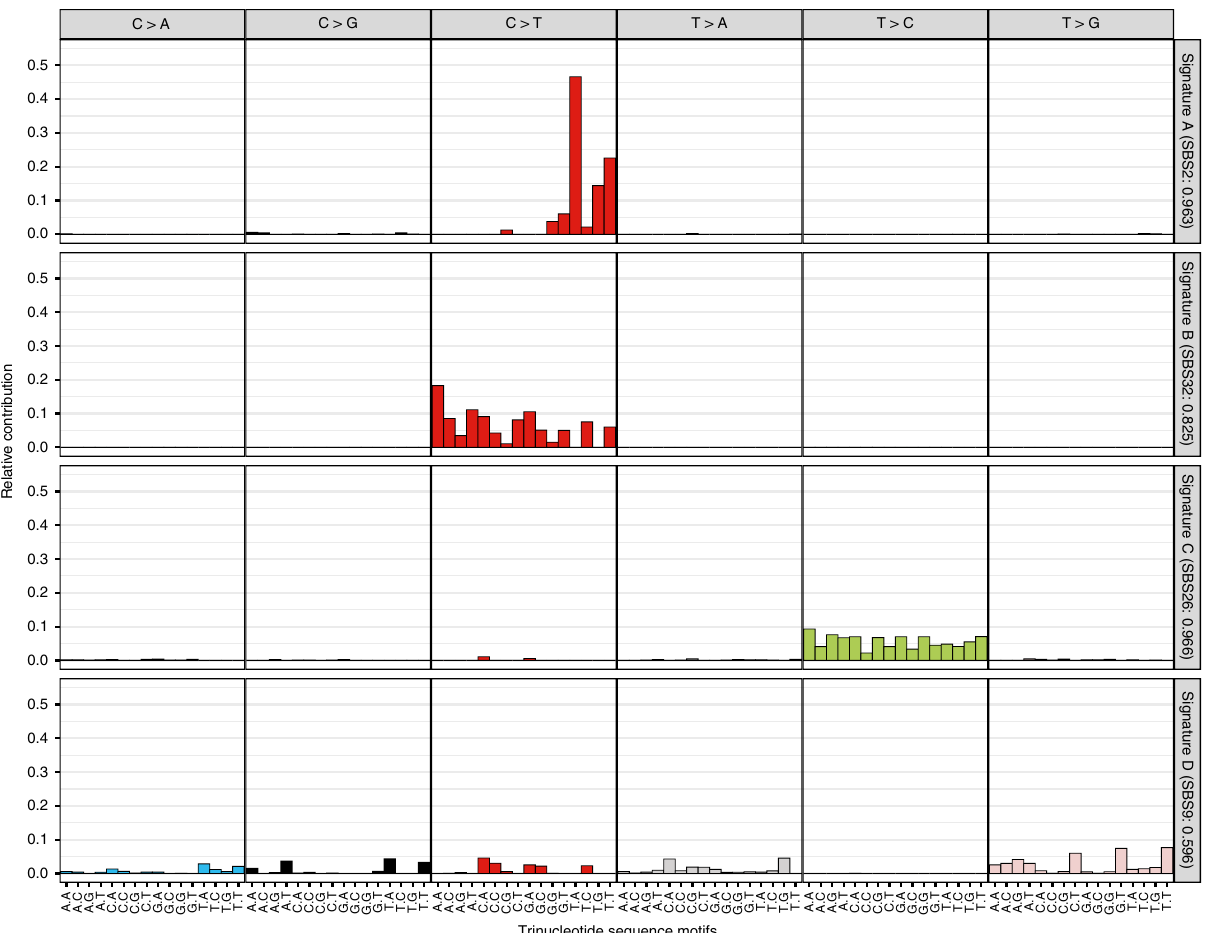
Fig. 1 Four de novo mutational signatures identi fi ed using all variants across the HPV16 genome in women from the PaP cohort. The x -axis indicates the 5 ′ and 3 ′ nucleotides for each of the top panel substitutions for the three base-pair motifs. The y -axis shows the single-base substitution (SBS) composition of each mutational signature by the 96 trinucleotide sequence motifs. For each identi fi ed signature, shown as A – D, the similarity was determined to the known COSMIC SBS signatures (https://cancer.sanger.ac.uk/cosmic/signatures/SBS/). The identi fi ed signature letter (A – D) and in parentheses the most similar COSMIC SBS signature number along with the cosine similarity are shown along the right y -axis. Cosine similarity ranges from 0 to 1, with a cosine of 1 indicating a perfect